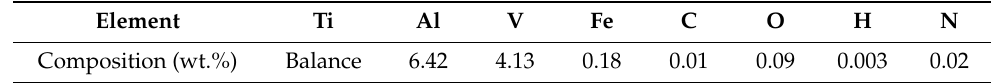
Table 1. Chemical compositions of Ti6Al4V powder.